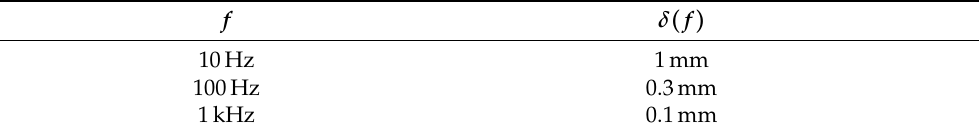
Table 5. Eddy current penetration depth for µ = 5000, σ = 5MSm − 1